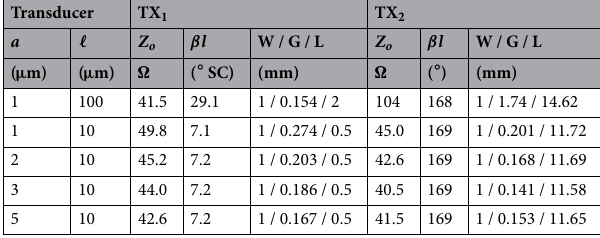
Table 1. CPW matching network parameters and